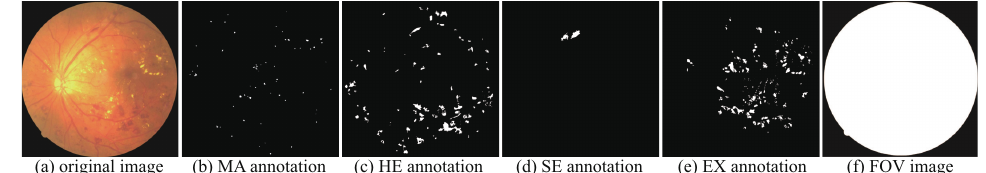
Figure 2. Illustration of fundus image, DR lesions, and FOV mask image.